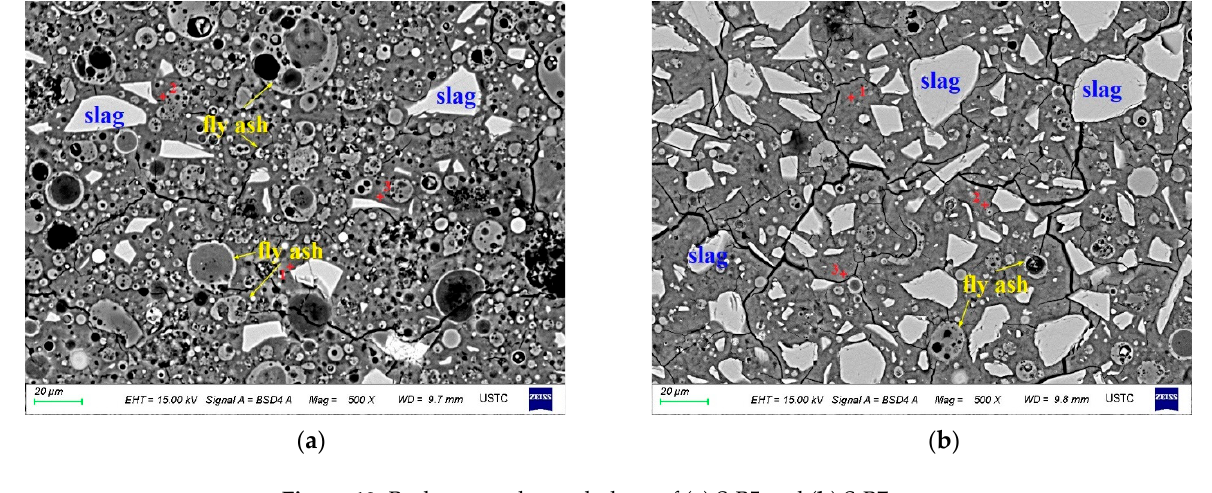
Figure 10. Backscattered morphology of ( a ) S-B5 and ( b ) S-B7.